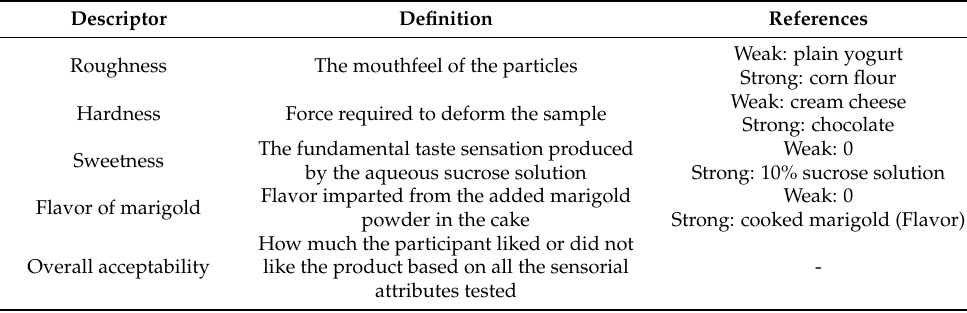
Table 1. Descriptors used for sensory evaluation of sponge cake with different MP particle sizes through quantitative descriptive